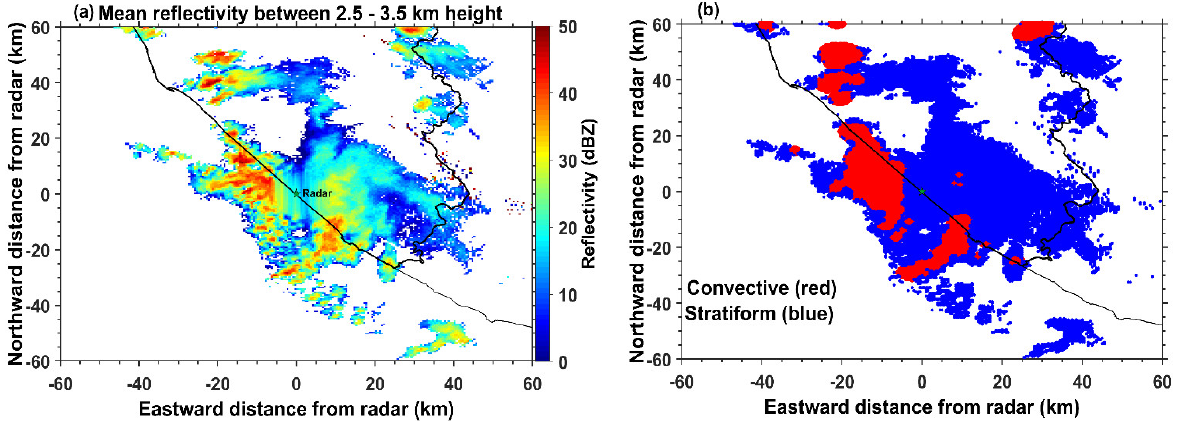
Figure 5. ( a ) PPI diagrams of radar reflectivity at 2° elevation averaged between 2.5 and 3.5 km height at 18:54:12 IST, on 13 May 2018 and ( b ) the identified convective (red) and stratiform (blue) regions.